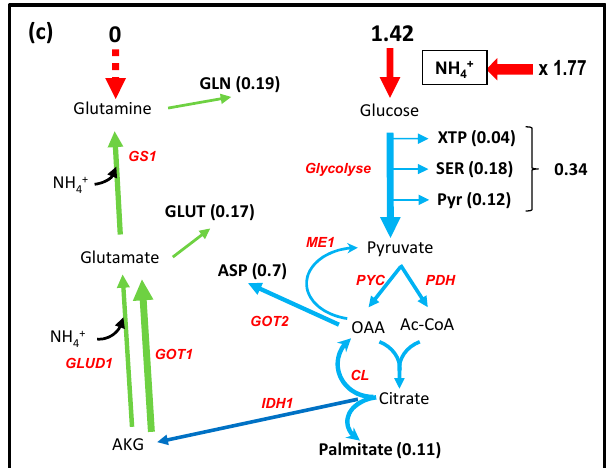
Figure 8. The interplay between glutamine, ammonia, and glucose to sustain cell proliferation. ( a ) Nitrogen is incorporated as a large excess of glutamine with release of ammonia. ( b ) Ammonia produced by GLS1 is stoichiometrically recycled by GLUD1(glutamate dehydrogenase) in the reverse direction. In ( c ), nitrogen is incorporated as ammonia in glutamate by the reversion of glutamate dehydrogenase and in glutamine by glutamine synthase. A small part of NH 4+ is incorporated directly by CPS1 (carbamyl phosphate synthase). The complete metabolic networks are in Figures S8a, S8b, and S8c.